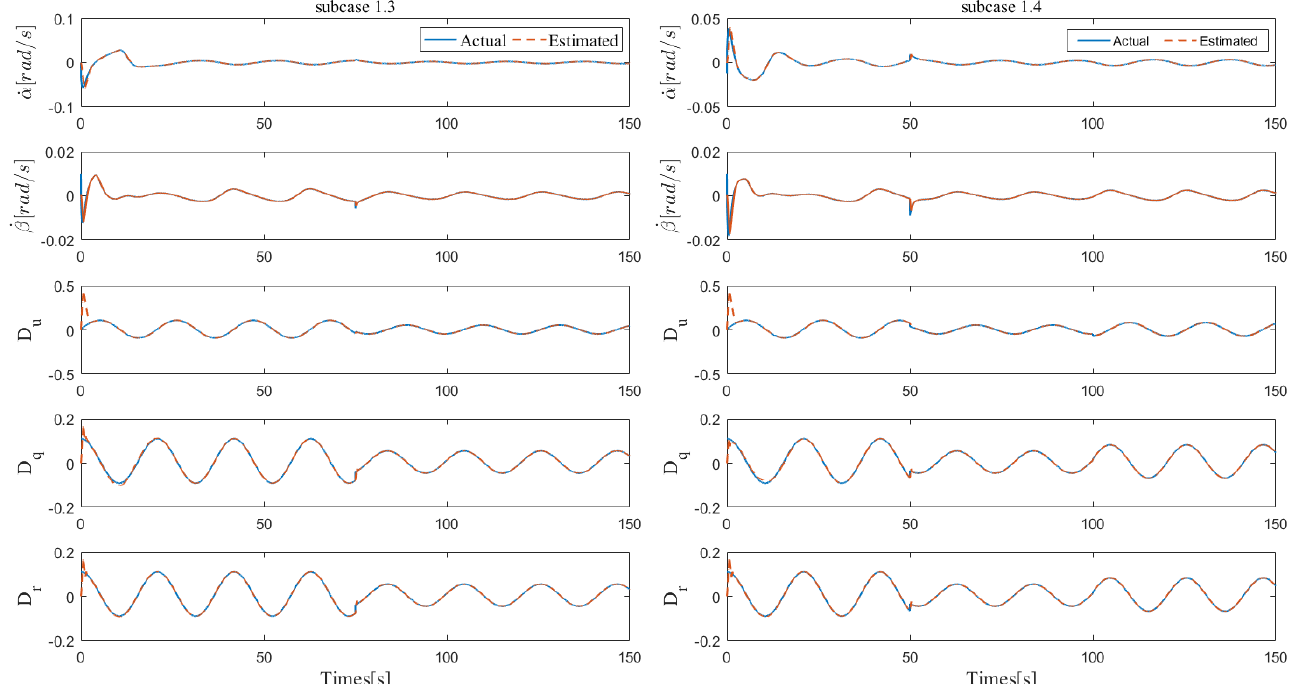
Figure 6. Disturbance estimations of subcases 1.3 and 1.4.